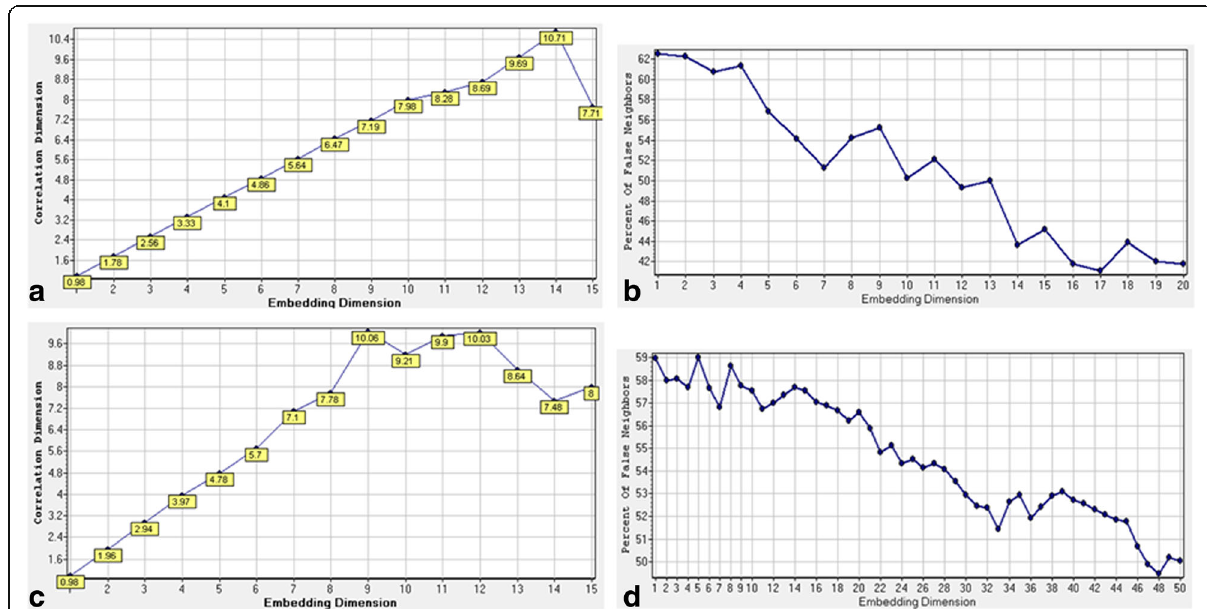
Fig. 13 Correlation dimensions (left hand frames) and false nearest neighbour (right hand frames) plotted against embedding dimension. a , b Data set: CNST_e. c , d Data set: CNST_u